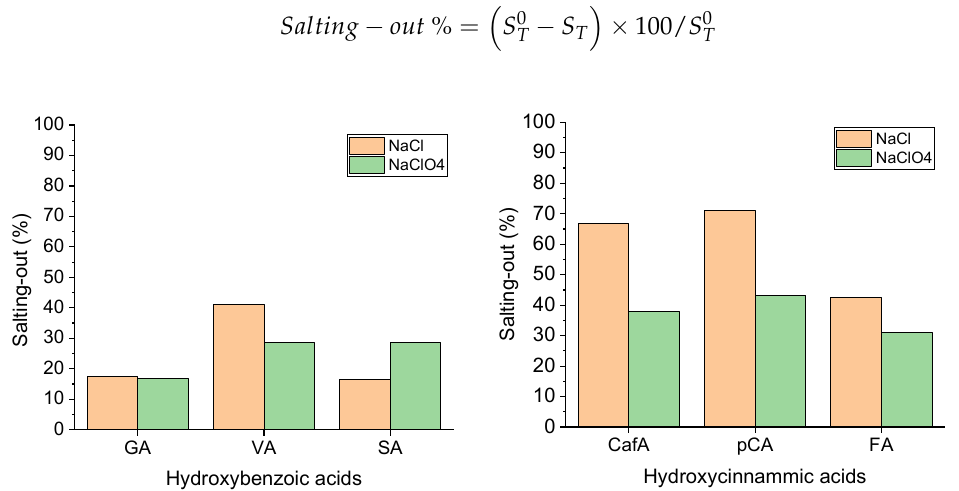
Figure 3. Salting-out effect calculated at the highest ionic strength for the two series of acids and in both electrolytes.